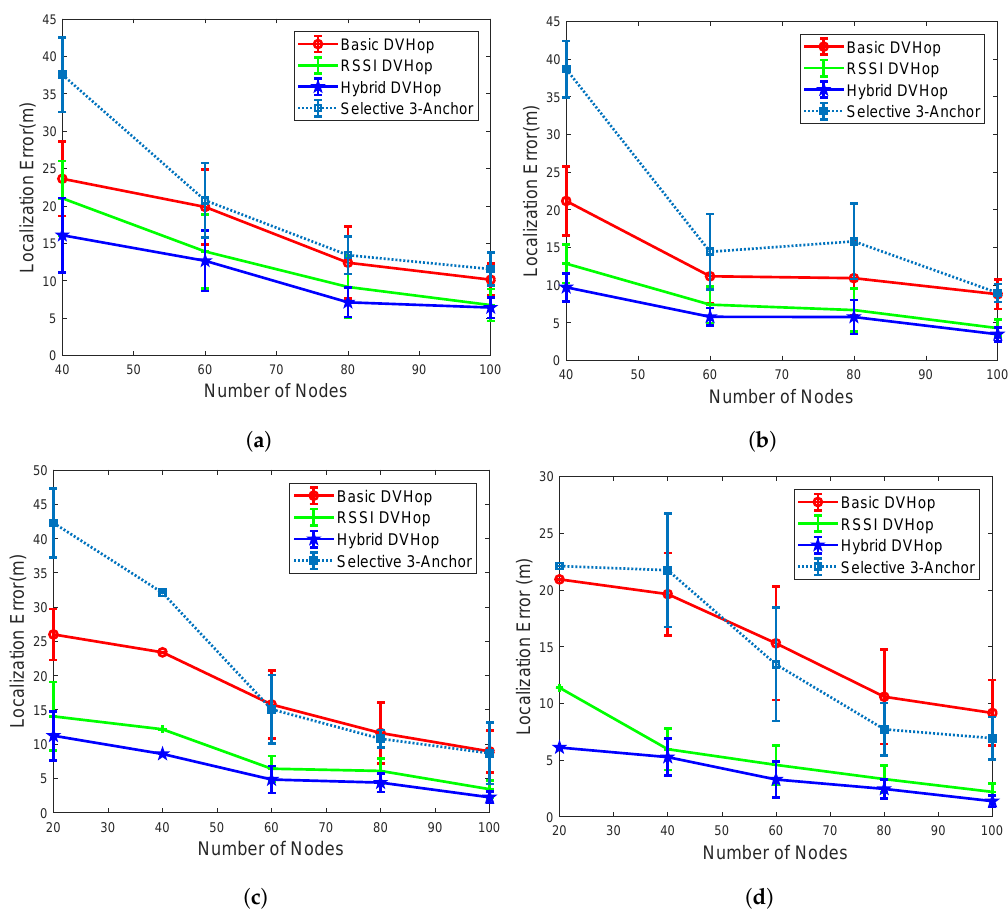
Figure 3. Localization error vs Number of nodes. ( a ) Anchor Rate = 10%; ( b ) Anchor Rate = 20%; ( c ) Anchor Rate = 30%; ( d ) Anchor Rate =